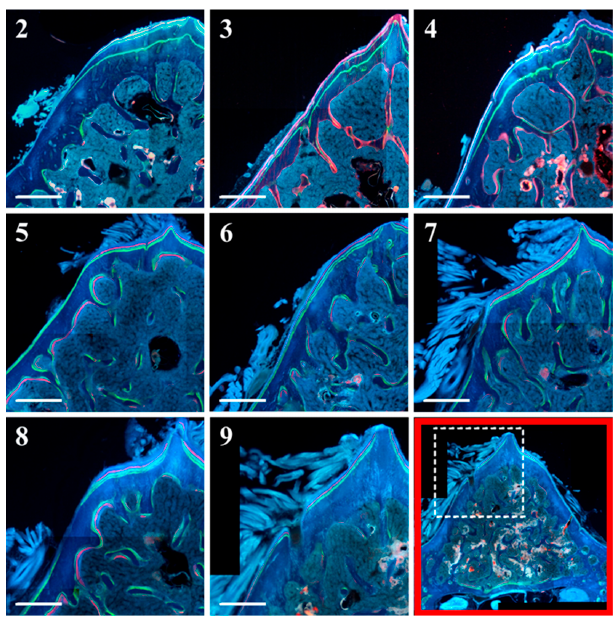
Figure 3. Micrographs of transverse sections of the anterolateral portion of L5 body from all animal groups under fluorescence microscope. In the bottom right image (outlined in red, as an example) the white dashed rectangle indicates the vertebral portion showed in all micrographs (2–9). Note on the surface of the few trabecular remnants (groups 3 and 4) the abundant red fluorescence. Note also, in the anterolateral cortex of the periosteal side (all groups), the presence of the three labels; in normal diet restoration only (groups from 5 to 8), the labels are well visible also on the endosteal side. Scale bar: 500 μ m.